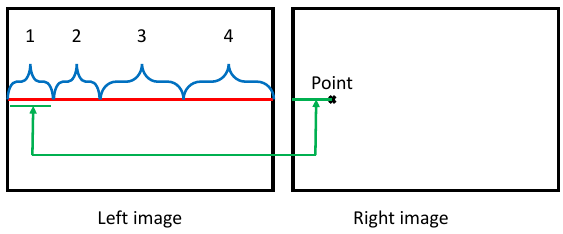
Figure 4. Illustration of stereo matching search ranges. (1) Impossible (2) Impossible in deep underwater imaging due to light’s fading at far distances, where features are undetectable (3) Possible disparity (4) The point is very close so it becomes overexposed and undetectable.